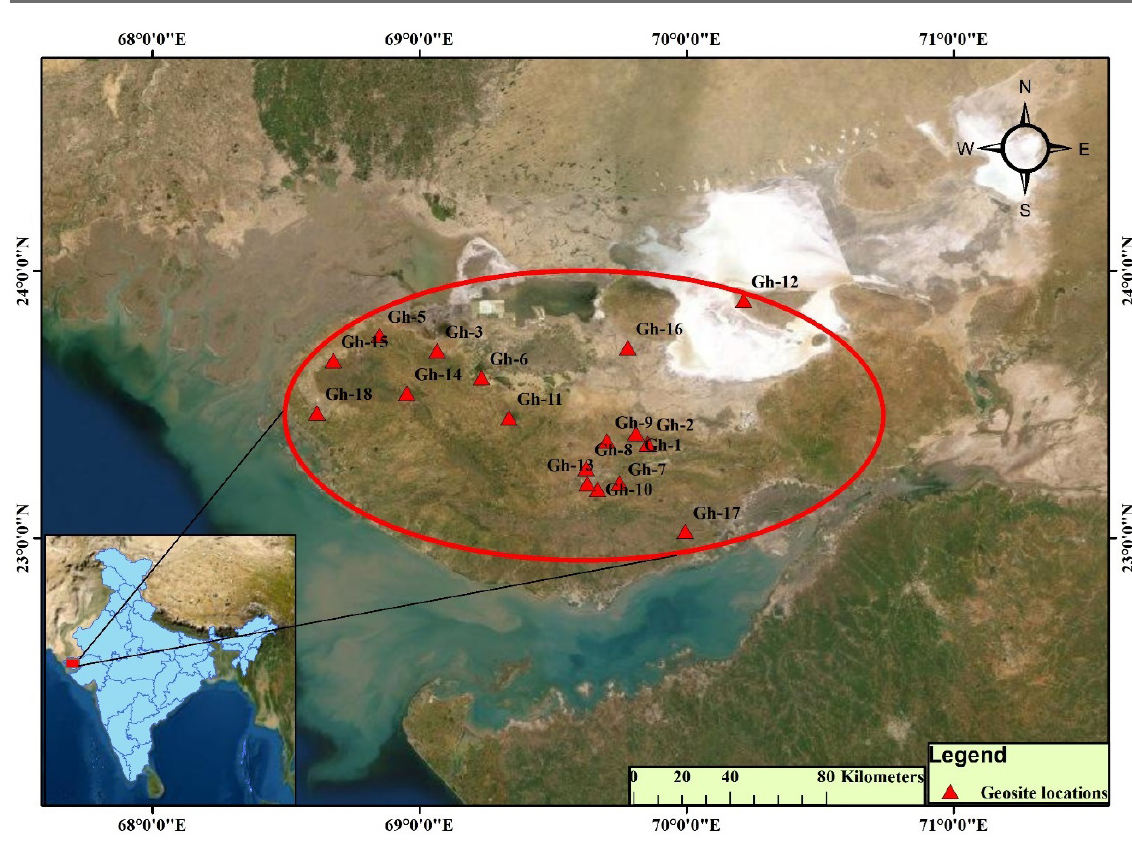
Figure 1. Location of various geosites.